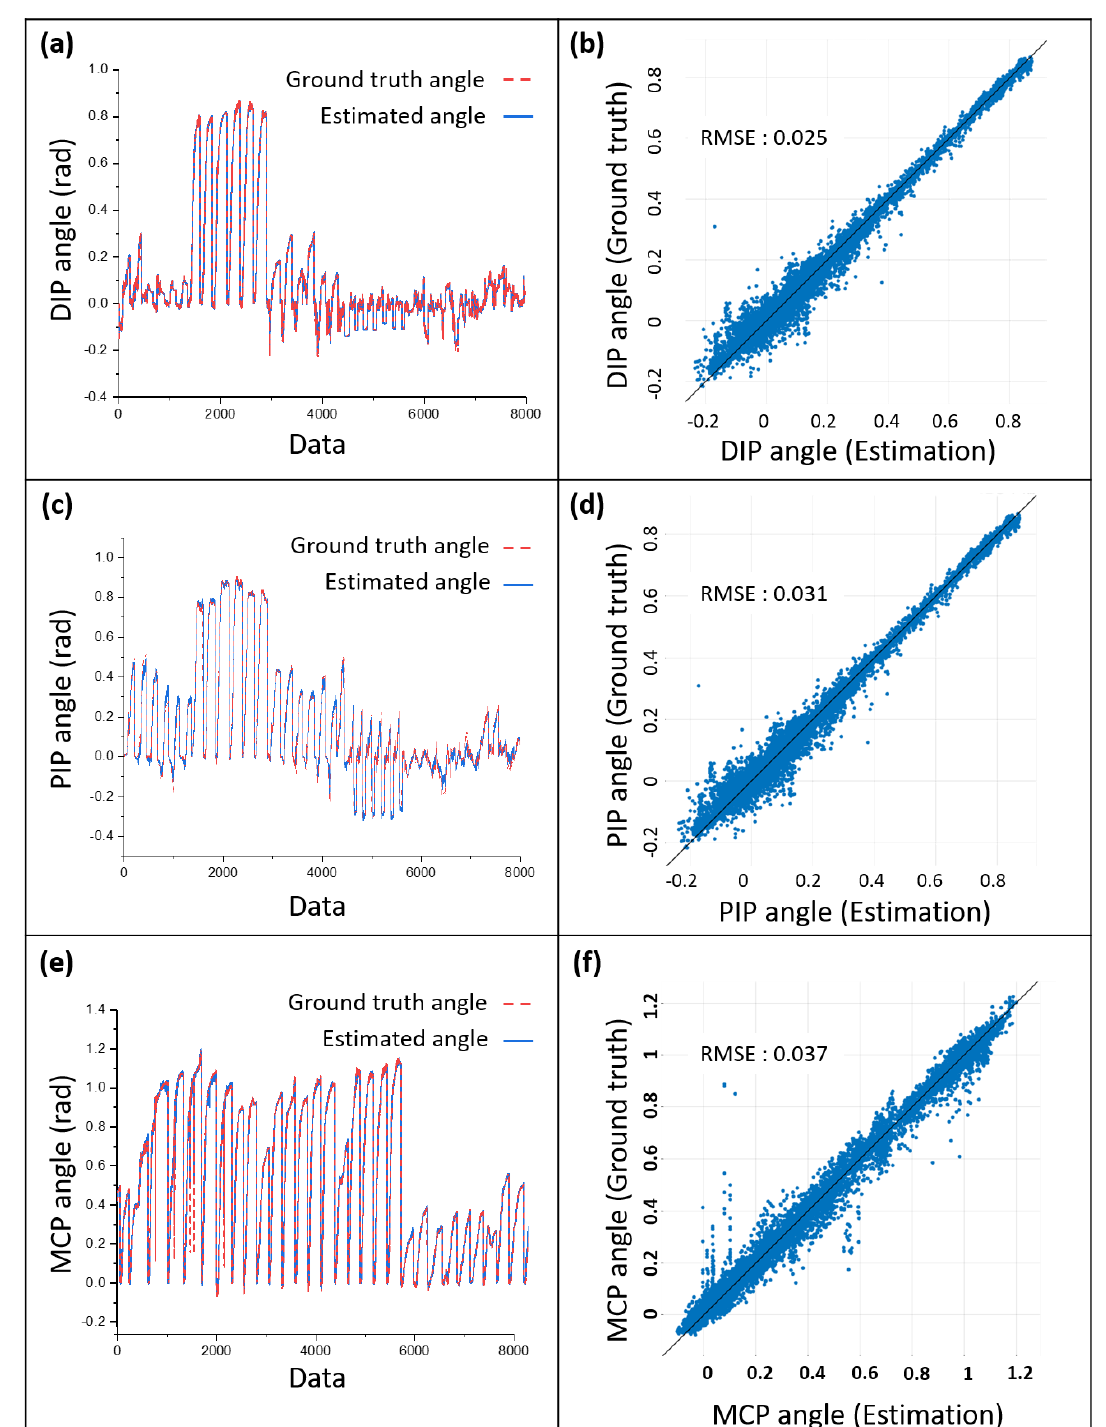
Figure 10. Experimental results of the stiffness parameter estimation that shows a relationship between the joint angle and the wire tension. ( a , c , e ) are plots of the ground truth angles measured by Vicon cameras and estimated angles using the wire tension and wire stroke. ( b , d , f ) are comparisons between the estimation and the ground truth. The RMS error indicates the disparity from the y = x